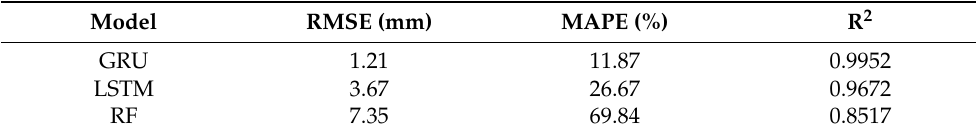
Figure 15. Predicted and measured periodic displacement. Table 3. Prediction accuracy of periodic